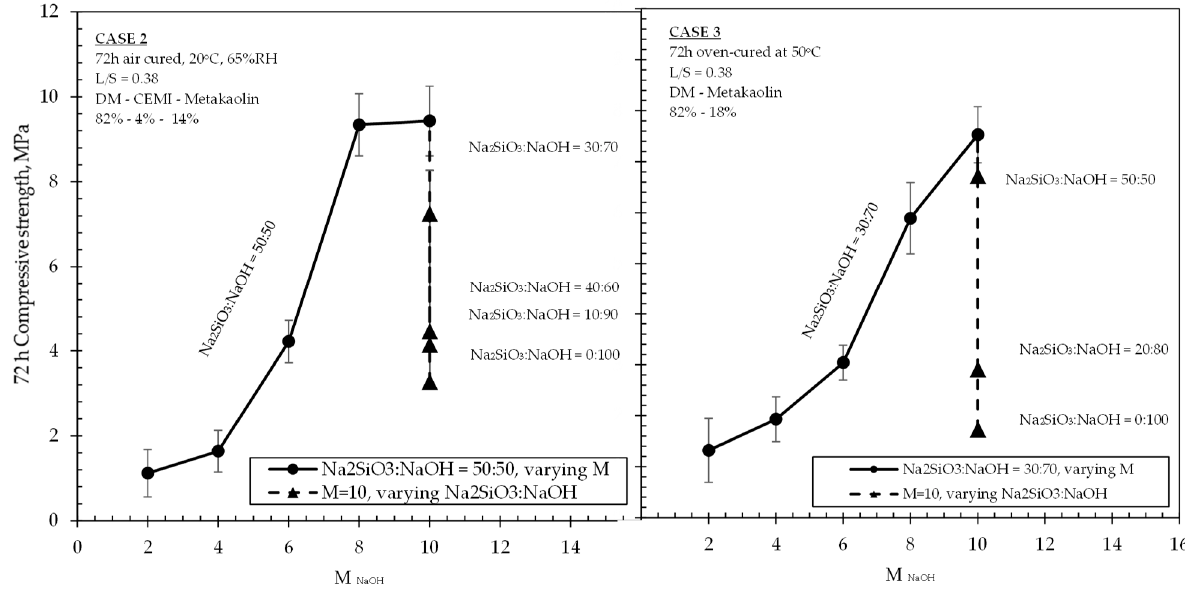
Figure 5. Effect of NAOH molarity and Na 2 SiO 3 : NaOH ratio on the 72 h strength of formulations at Cases 2 ( left ) and Case 3 ( right ).